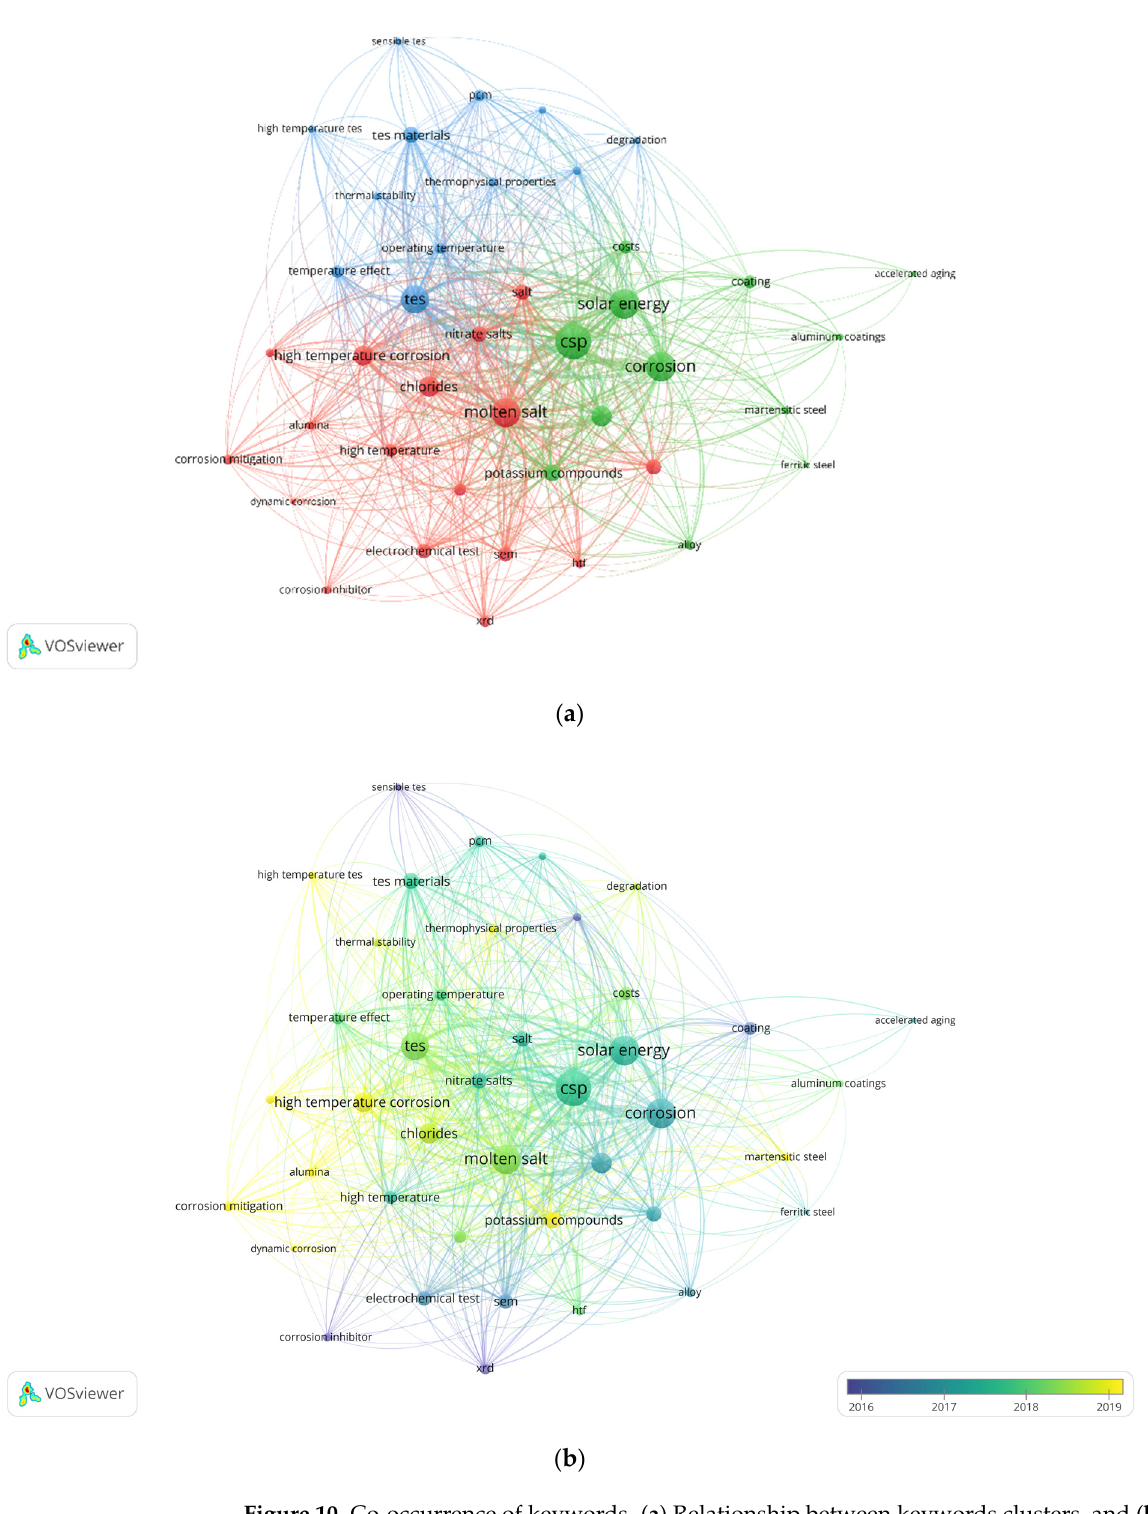
Figure 10. Co-occurrence of keywords. ( a ) Relationship between keywords clusters, and ( b ) High- lights of the date of publication. lights of the date of